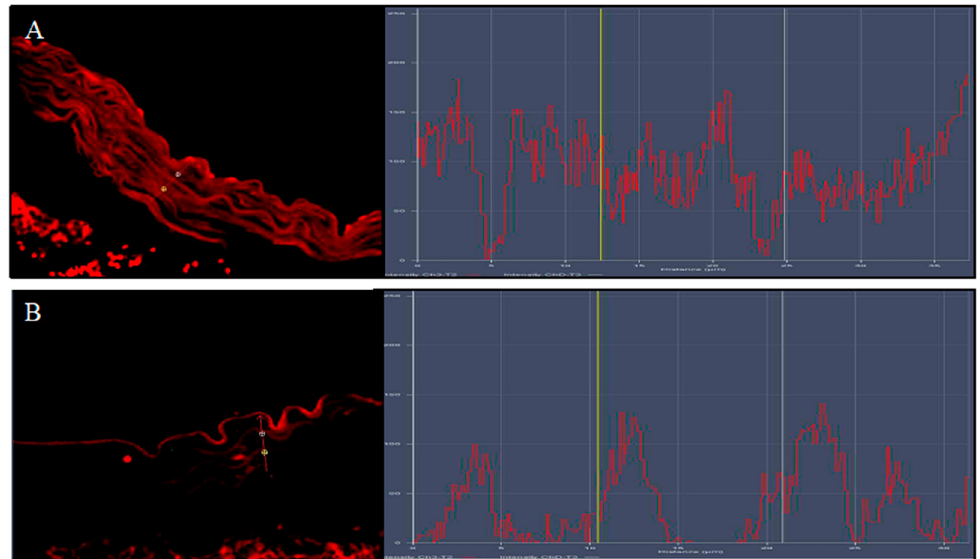
Figure 5. The images show the display profile obtained by the confocal laser; a high intensity of fluorescence pattern for Nfr2 was observed in ApoE KO + HFD + Lycopene mice ( A ) compared to the fluorescence pattern observed in untreated ApoE KO + HFD mice ( B ).